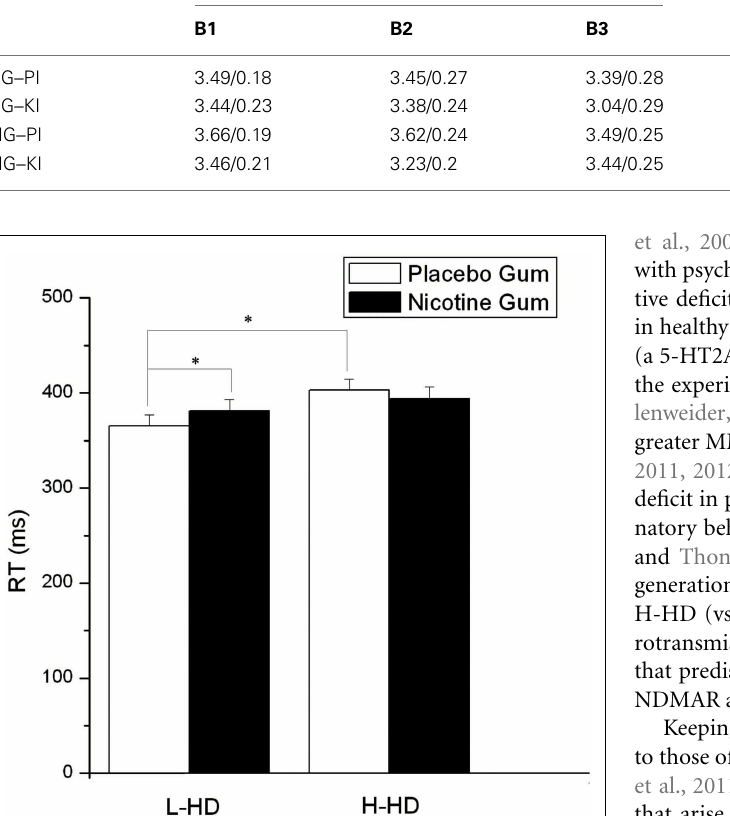
antagonist, MK-P01, and memantine (Tikhonravov et al.,